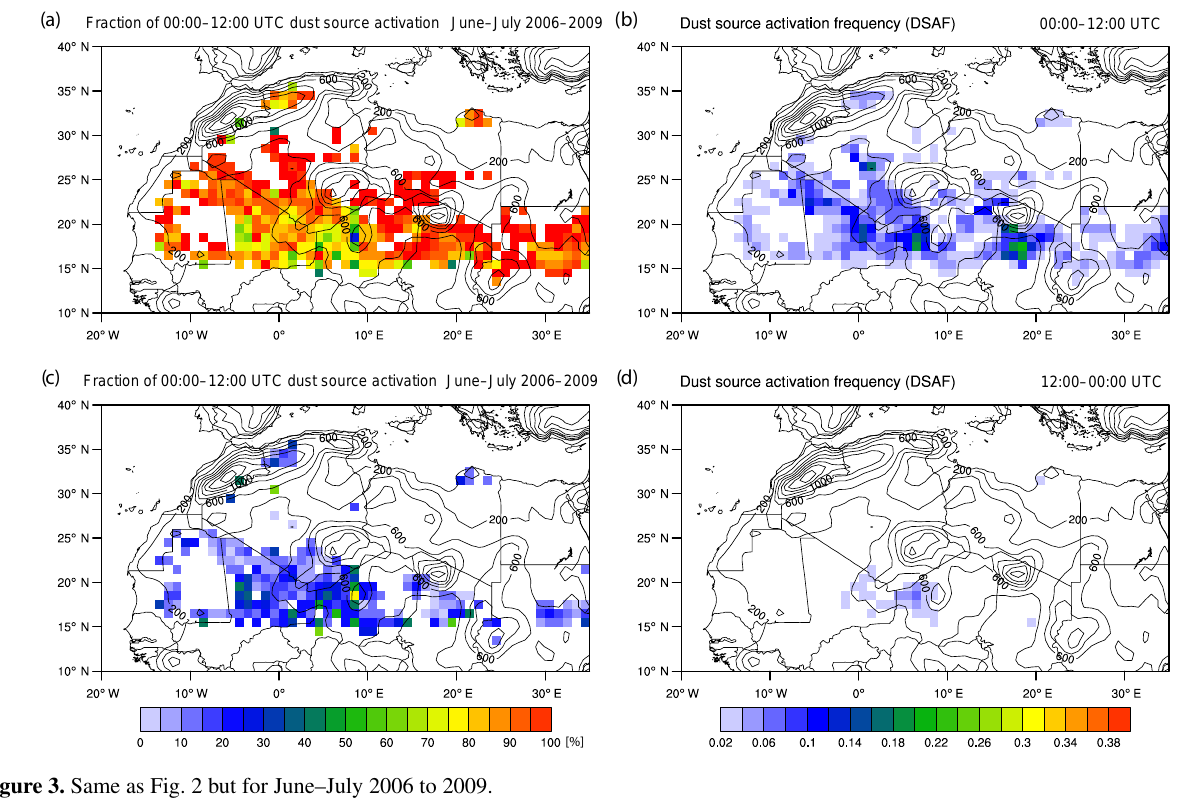
Figure 3. Same as Fig. 2 but for June–July 2006 to